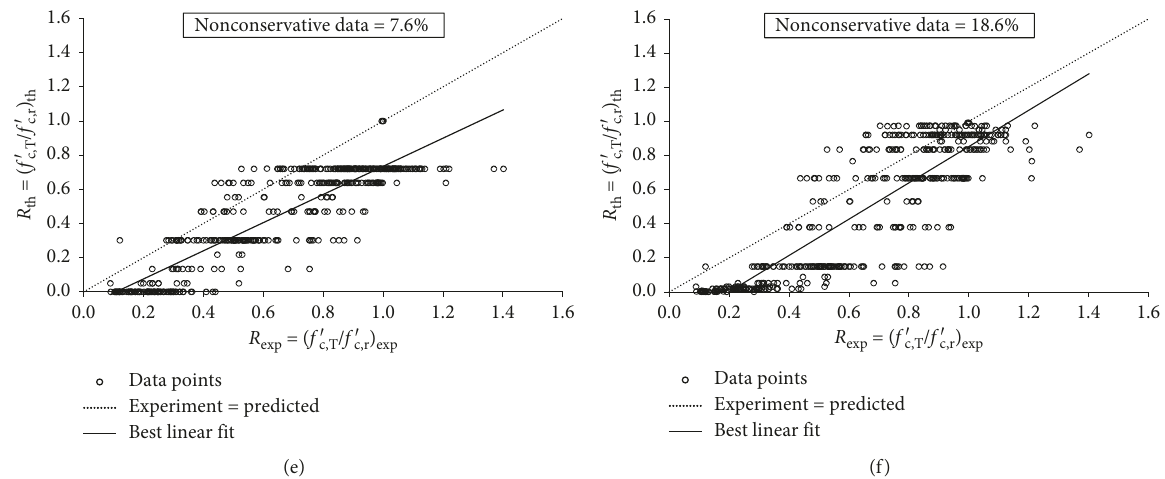
Figure 11: Comparison of normalized strength of HSC predicted by the models of different researchers with experiment: (a) Kodur et al.